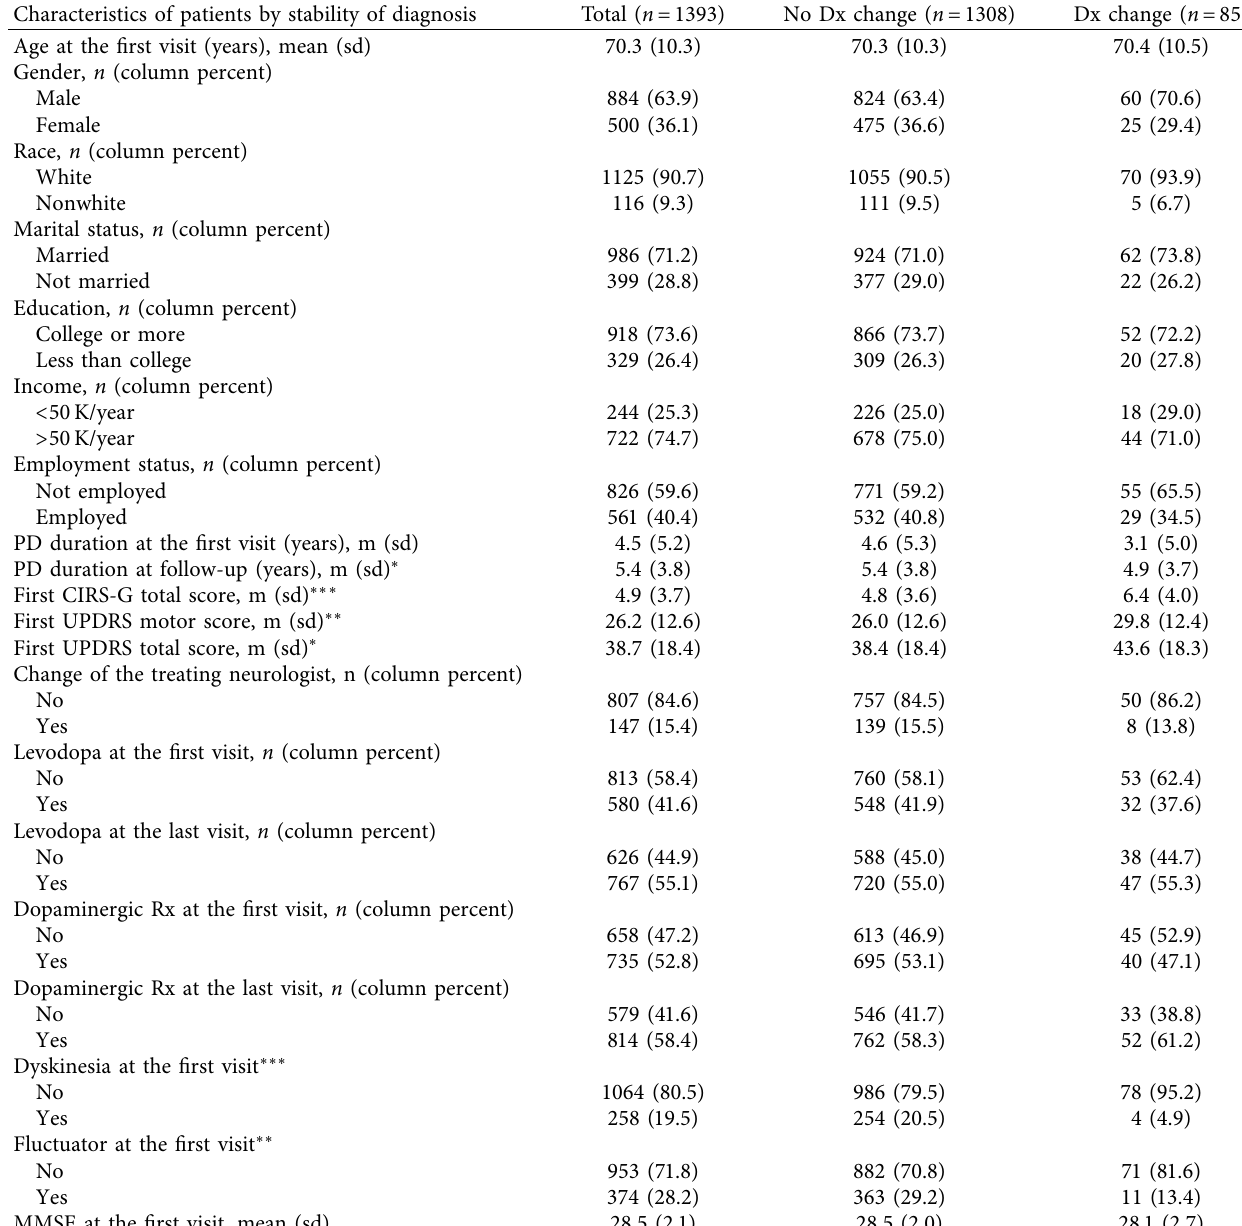
Table 1: Characteristics of patients by stability of